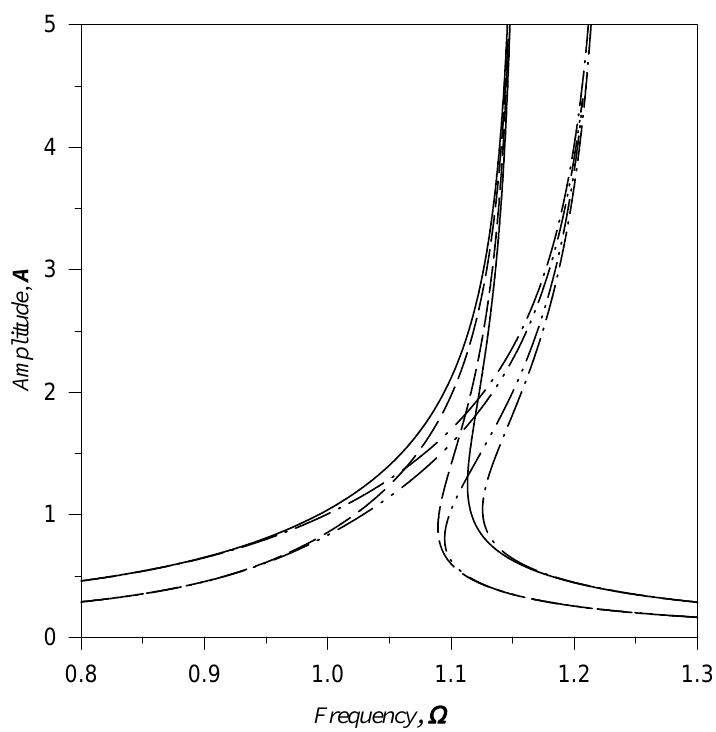
Fig. 2. Steady state frequency response of equations (30, 38) for the case ε 1 = 1 . 0449 , ε 2 = 0 . 9329 , ε 3 c = 0 . 17974 , ε 3 d = 0 . 100623 , δ = 0 . 02 and P = 0 . 2 , corresponding to the first mode of the immersed cantilever beam in Fig. 1, for the cases; concentrated and distributed loads. —— SHB-C, – - – 2HB-C, – – – SHB-D, – - - –